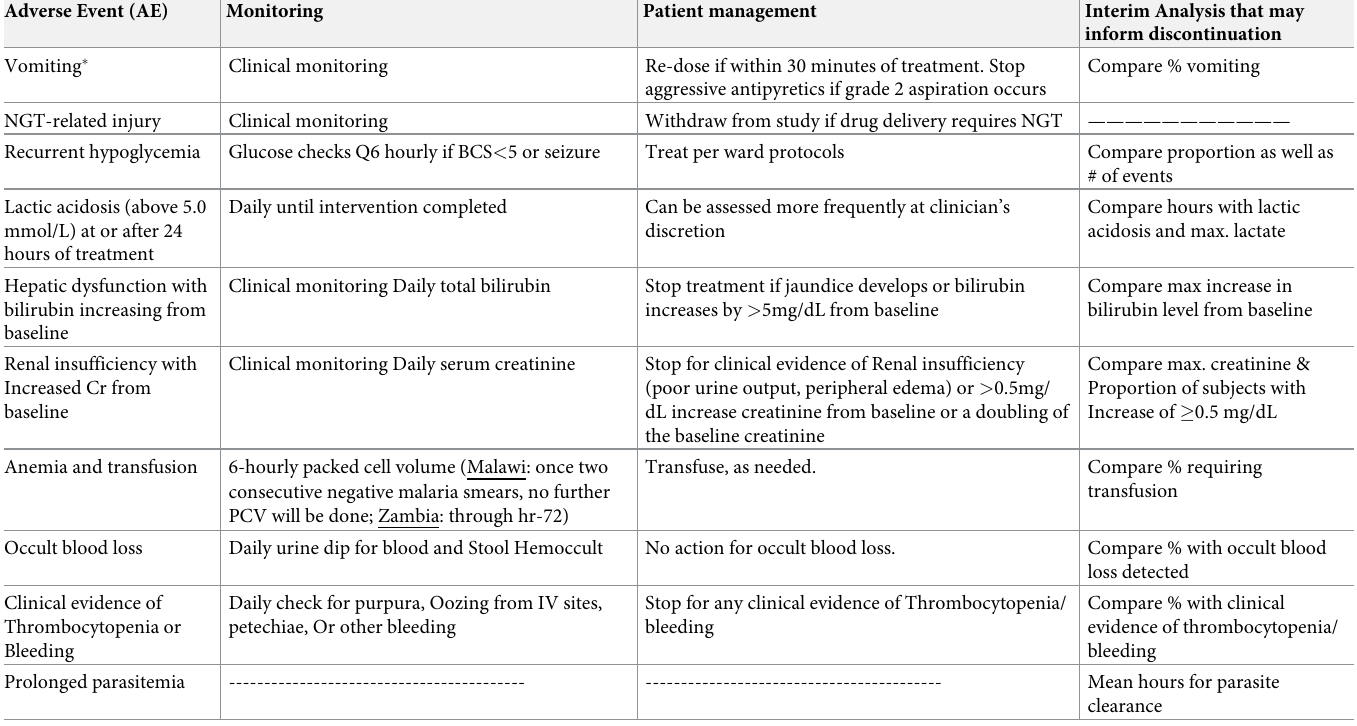
Table 3. Plan for monitoring and